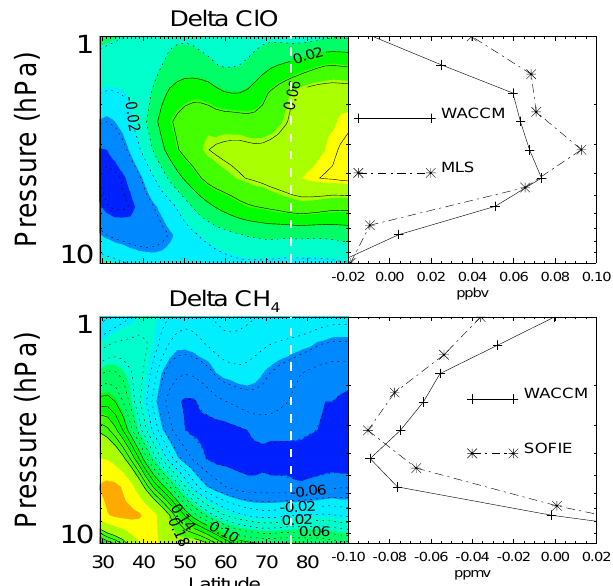
Figure 4. The color contours on the left are zonal mean WACCM/NOGAPS difference fields for August 2009 minus Au- gust 2008 for ClO (top) and CH 4 (bottom). The vertical dashed white line is the mean latitude of the SOFIE occultations for August. On the right, a vertical profile of the model difference at the SOFIE occultation latitude (solid line with plus symbols) is compared with MLS ClO and SOFIE CH 4 (data are dotted/dashed curves with stars). Note that x axes for the right panels are reversed from one another since the ClO change is positive, while the CH 4 change is negative.